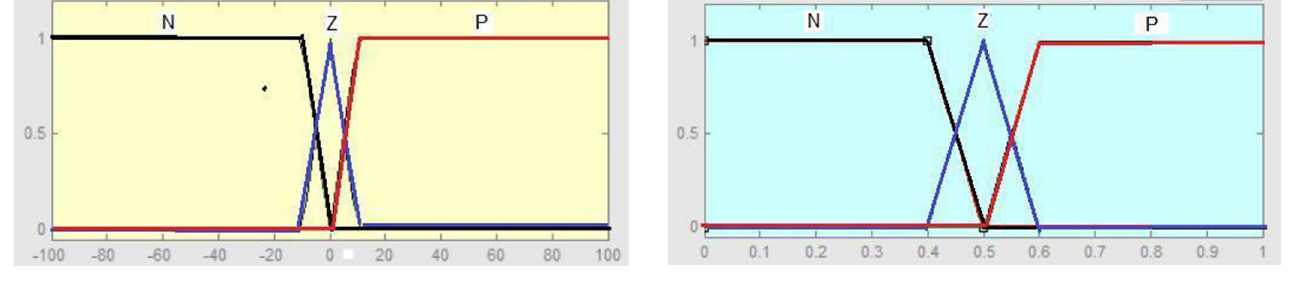
Fig. 10. Voltage variation membership function.